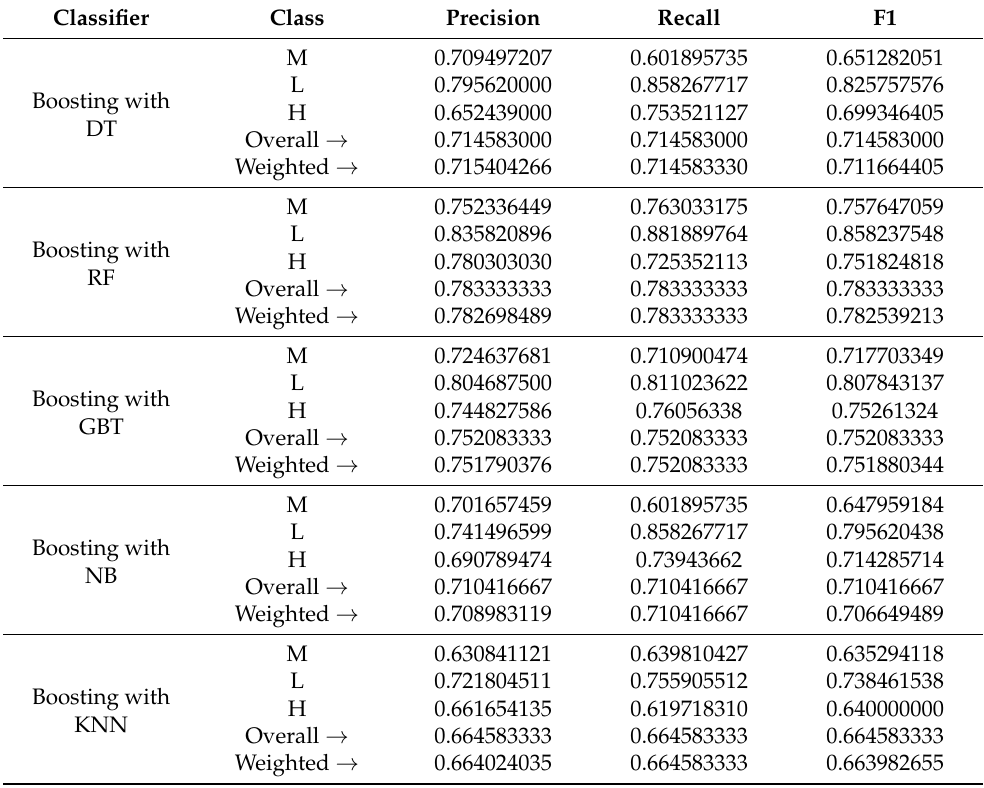
Table 5. Performance metrics for all ML models—with ensemble method II (boosting).